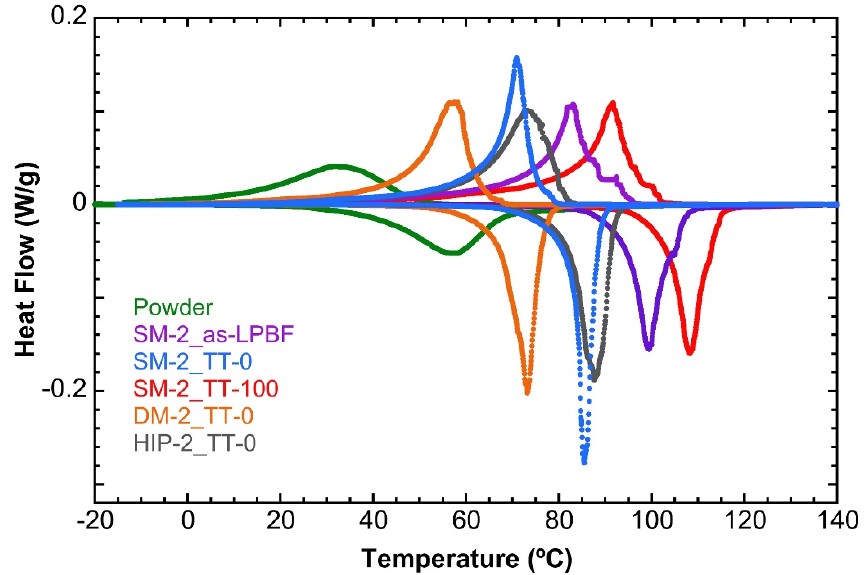
Figure 13. Summary of the obtained DSC results. Atomized powders (green curve) and as–LPBF single melt sample (violet curve). LPBF samples after slow quench TT–100 treatment (red curve) and after fast quench TT–0 treatment (blue curve). LPBF single melt plus HIP–treated TT–0 (dark grey curve) and LPBF double melt plus TT–0 treatment (orange curve). See the text for the explanation and discussion.